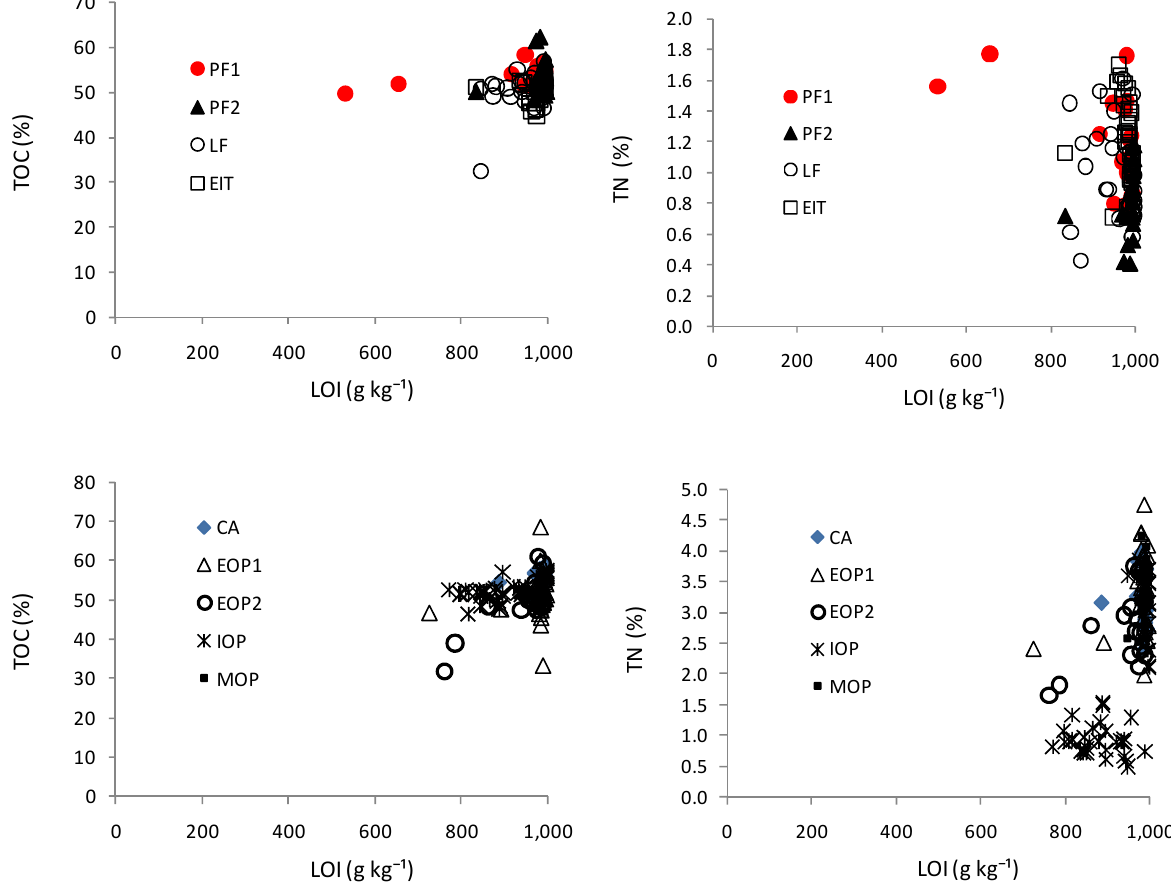
Figure 5. Scatter plots of LOI versus C/N Ratio according to Land Use Groups (PF1= coastal peat forest; PF2= inland peat forest; LF = logged over peat forest; EIT = industrial timber plantation; CA= community agriculture; EOP1= Early Oil Palm (< 5 yrs) in coastal peat; EOP2 = Early Oil Palm (<5 yrs) in inland peat; IOP = Intermiediate Oil Palm (5-10 yrs); MOP = Mature Oil Palm (15-20 yrs)